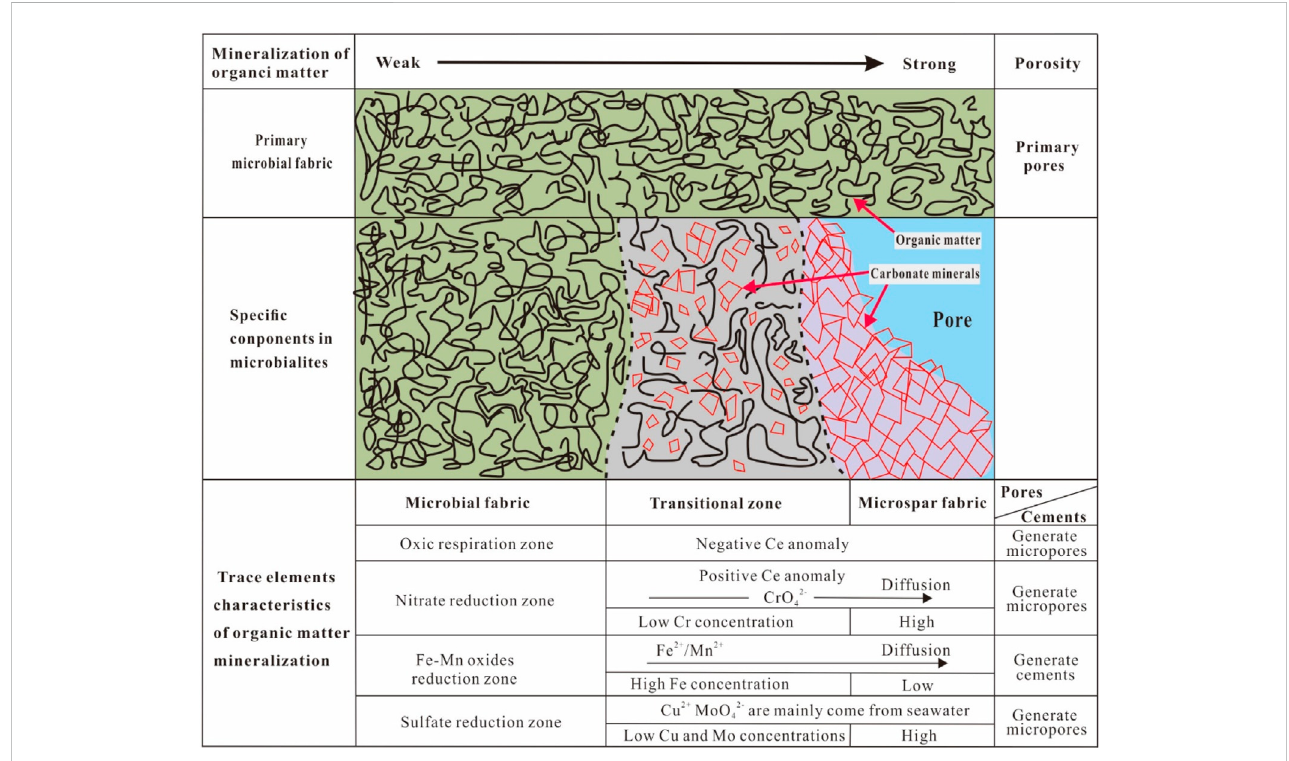
FIGURE 6 Pattern of organic matter minerlization, geochemistry characteristics, and porosity evolution in microbialites.